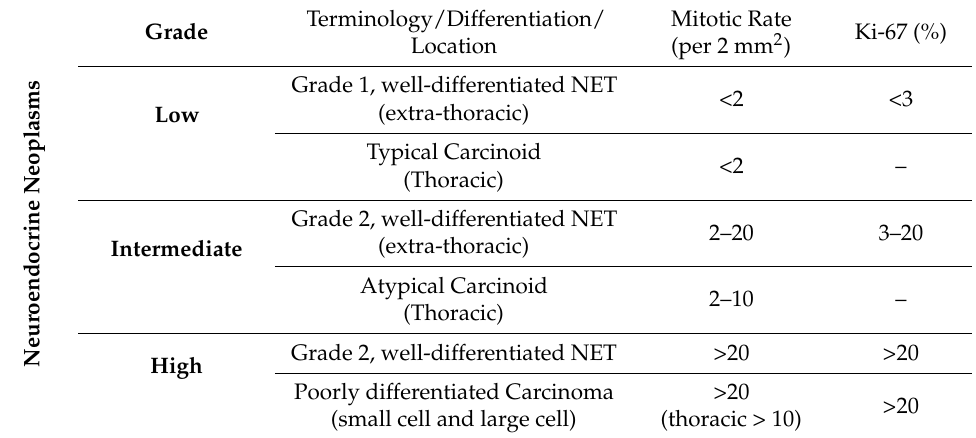
Table 1. Classification of neuroendocrine neoplasms adapted from the WHO classifications up through 2022 as described previously